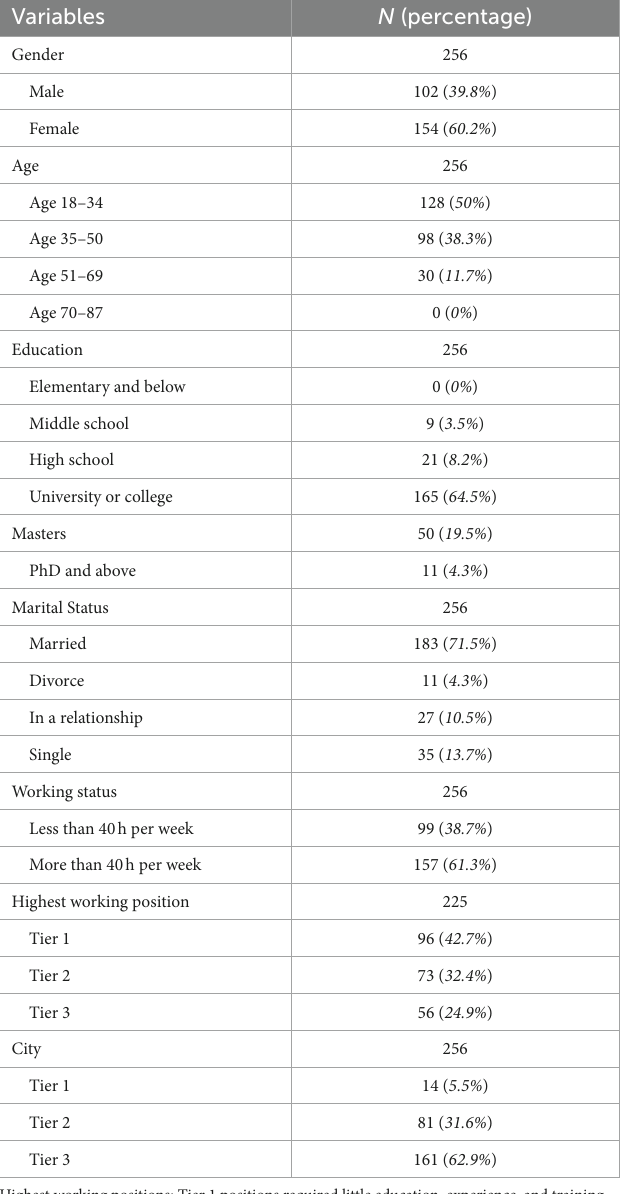
TABLE 1 Total responses ( N ) and percentages for each demographic variable.